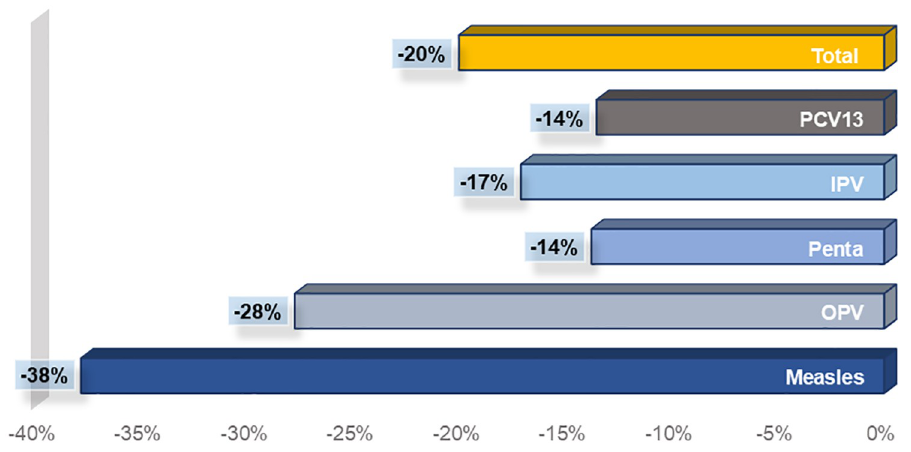
Fig 1. Overall changes in the number of vaccine doses administered in the public sector, between October 2019 and March 2020, as compared to the same period last year.